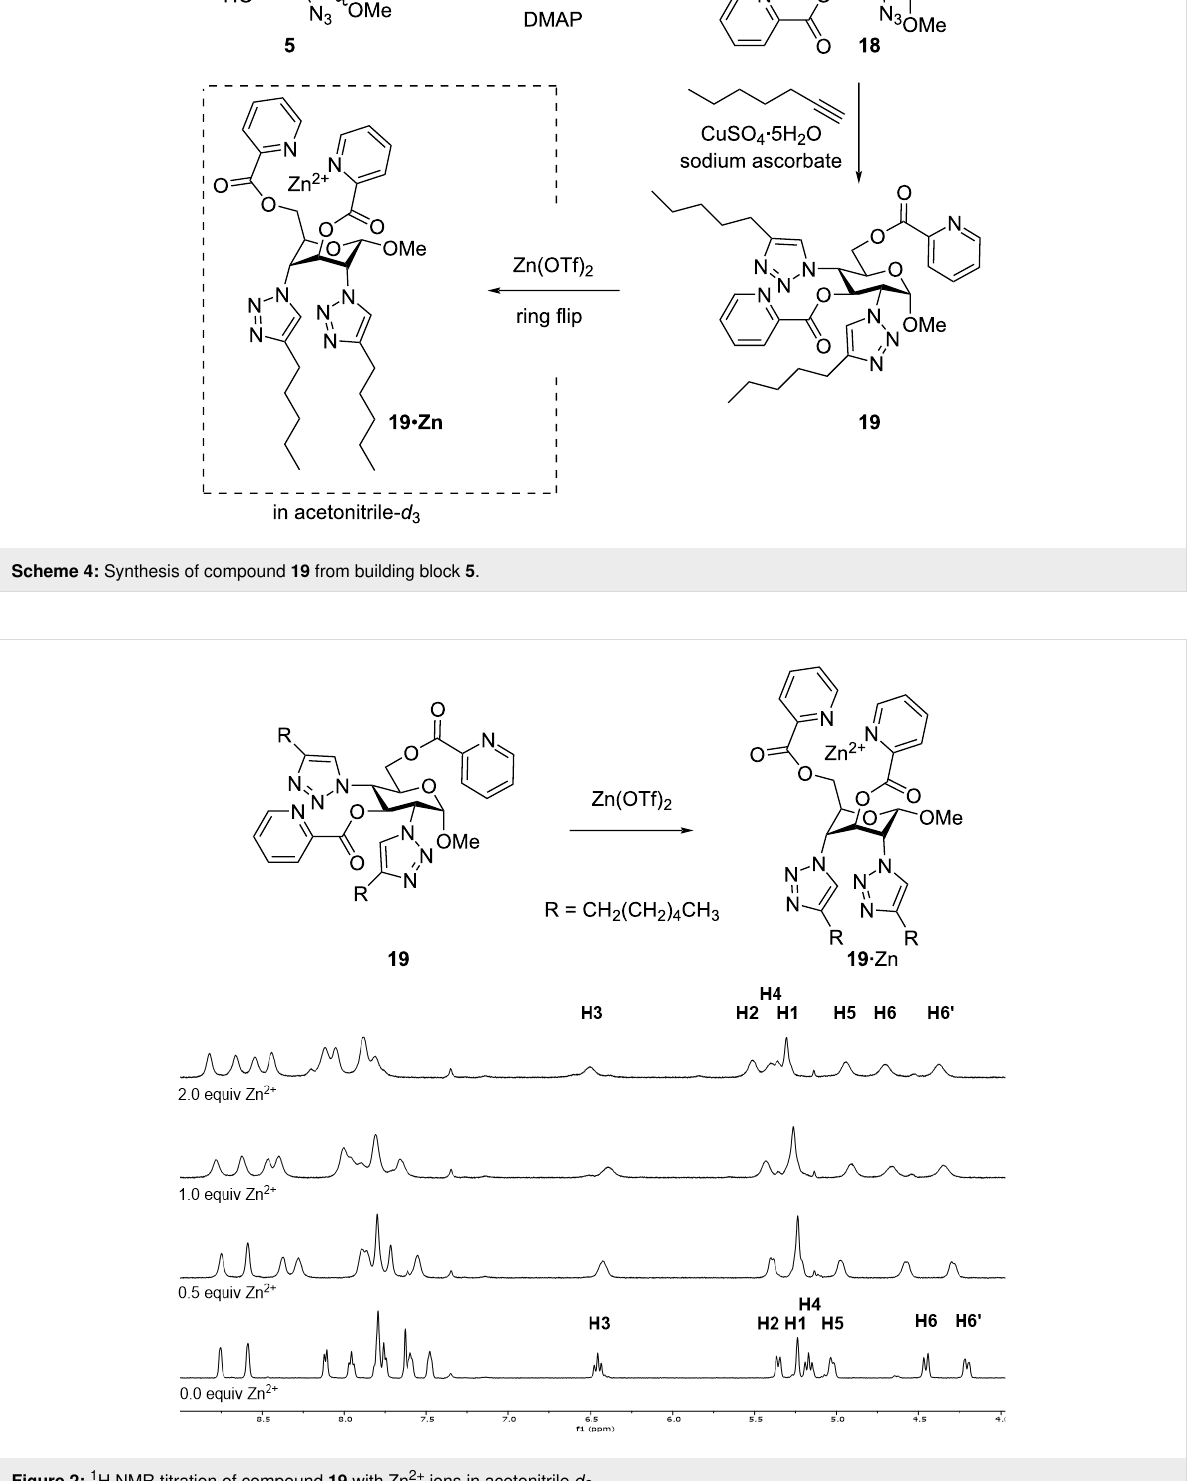
Figure 2: 1 H NMR titration of compound 19 with Zn 2+ ions in acetonitrile- d 3